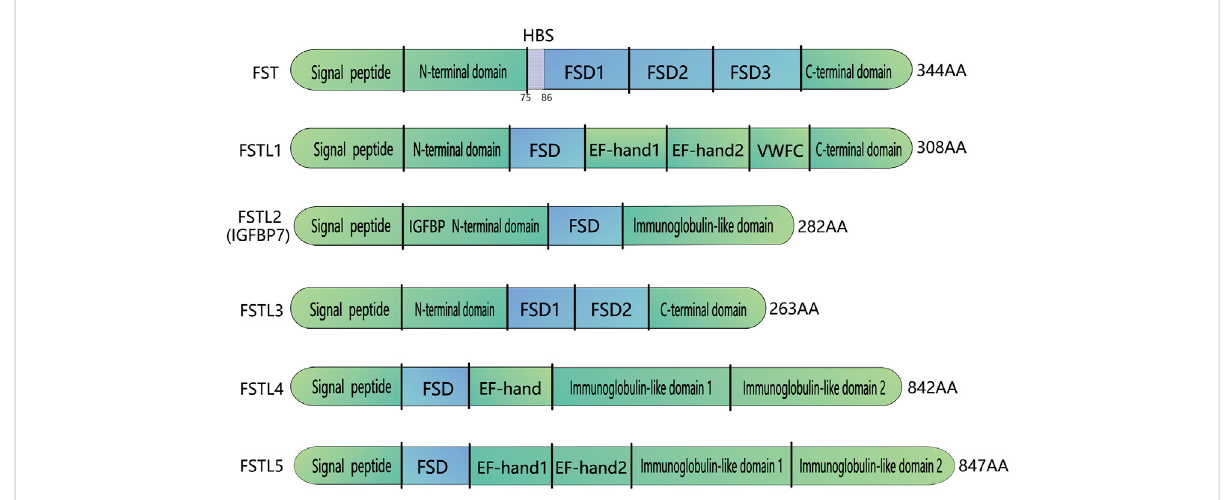
FIGURE 1 Domain organization of FST and FST-like proteins. FST-like proteins comprise FSTL1, FSTL2, FSTL3,FSTL4, FSTL5. All FST and FST-like proteins contain at least one FSD follistatin domain. FSTL3 does not have FSD3 and the HBS region located on FSD1. HBS: Heparin-binding sequence; FSD, Follistatin/kazal-like domain; EF, a helix-loop-helix structural domain; VWFC, von Willebrand factor type C domain; IGFBP, IGF-binding